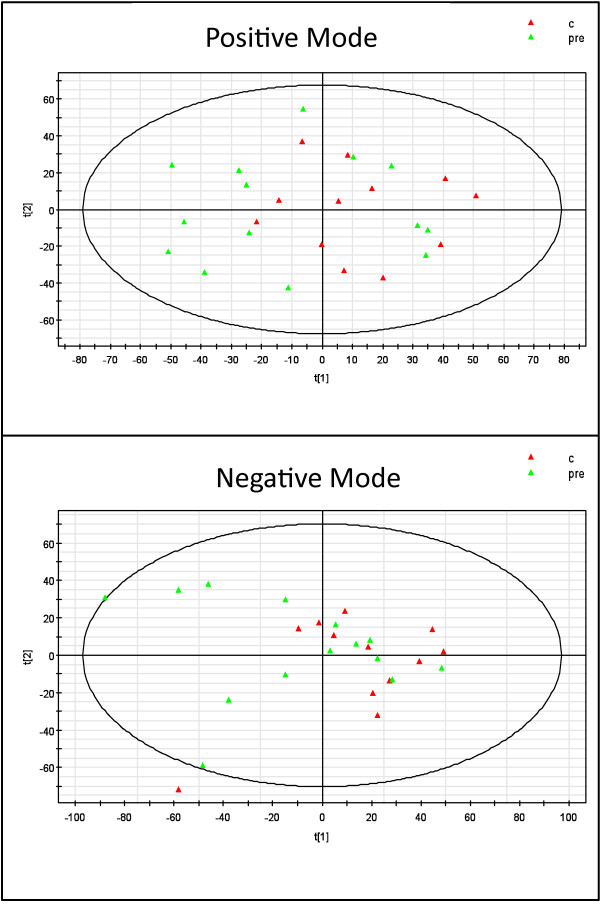
Principle components analysis models for all ions for all subjects detected in positive and negative mode.